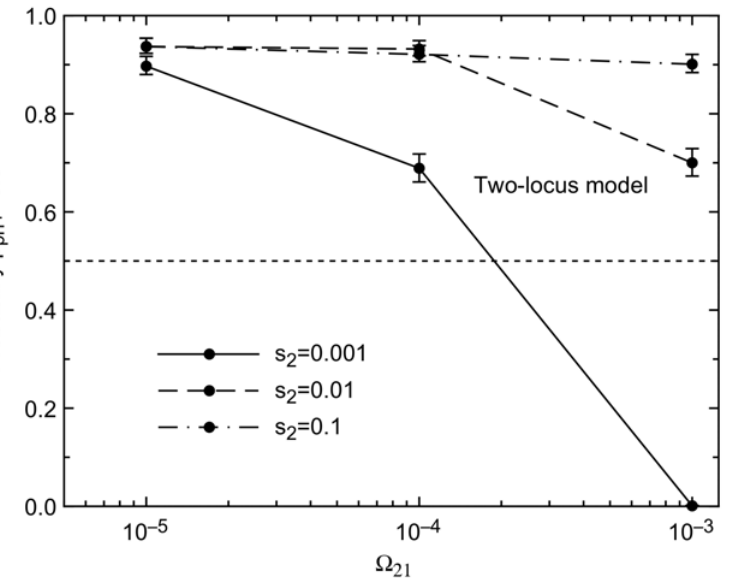
Figure 5. If environment 2 is too short-lived (high V 21 ), then prf + is not maintained. This is because there is insufficient time for the selective sweeps shown in Figure 3 to be completed. e =0.01, V 12 =10 2 5 , h =1.